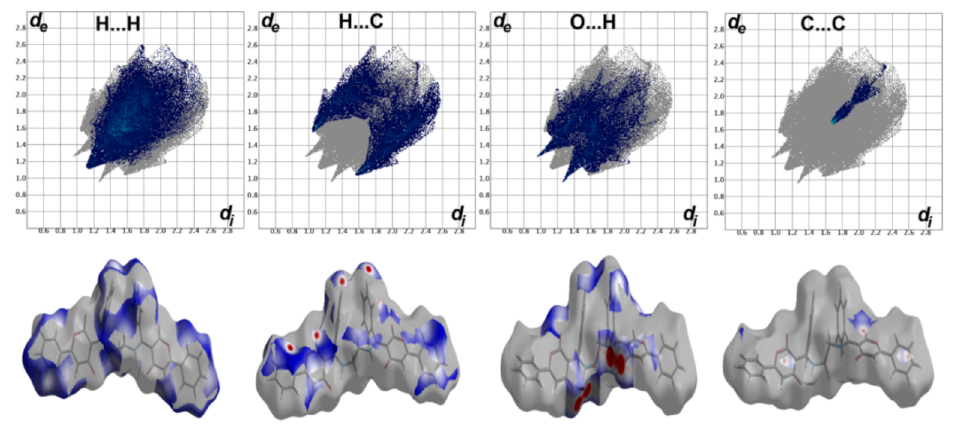
Figure 6. Decomposed fingerprint plots and d norm Hirshfeld surfaces of the most abundant interac- tions in 1